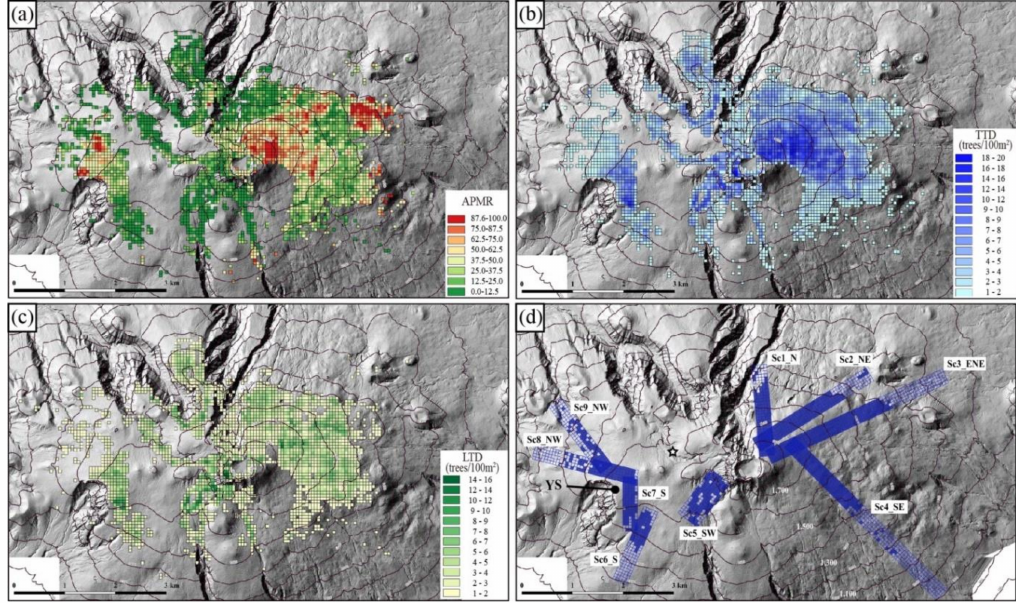
Figure 2. ( a ) Distribution maps of the APMR. ( b ) Total tree density. ( c ) Live tree density. ( d ) Location of the sections for the altitudinal variation analysis of the Korean fir, in relation to the aspect of Mt. Halla. The cells used for analysis, each containing at least 36 Korean firs, are filled in blue. The size of each cell in the figures is 60 × 60 m. The star in Figure 2d represents the location of the analysis for the distribution of Korean fir in the area with heterogeneous topography. The dot (YS) indicates the location of the Yeongsil area. APMR: accumulated percent mortality rate. TTD: total tree density. LTD: live tree